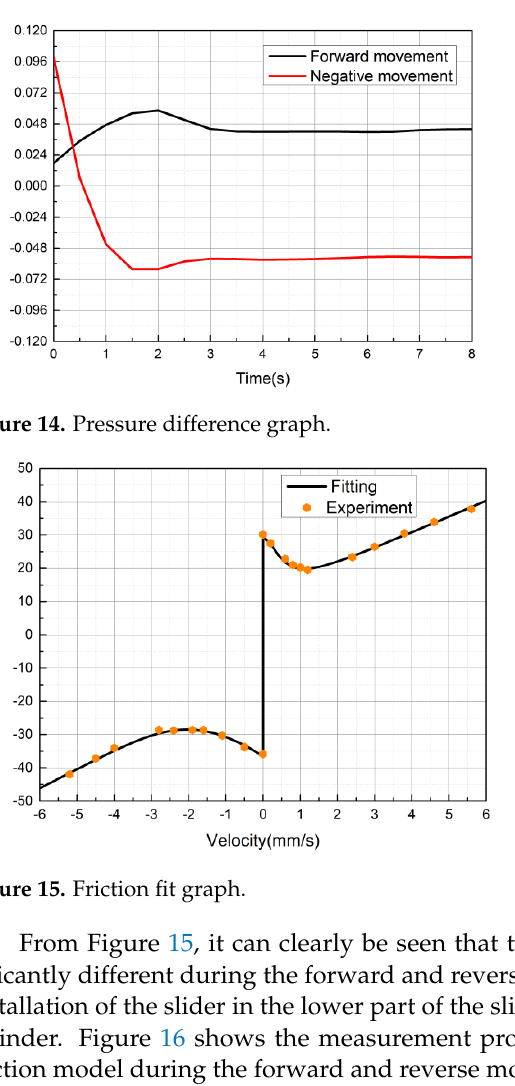
Figure 13. Displacement graph: ( a ) forward motion; ( b ) reverse motion.